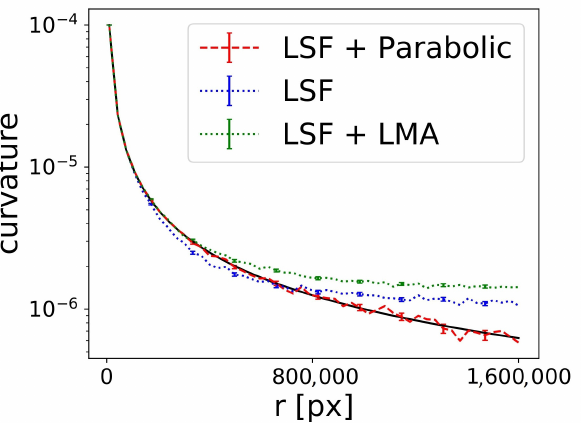
Figure A3. Synthetic emission line radius plotted against curvature acquired by different fitting methods. Parabolic fit is clearly the most stable and accurate of the three fitting methods when curvature is very low. The solid black line represents the ground truth 1 / r